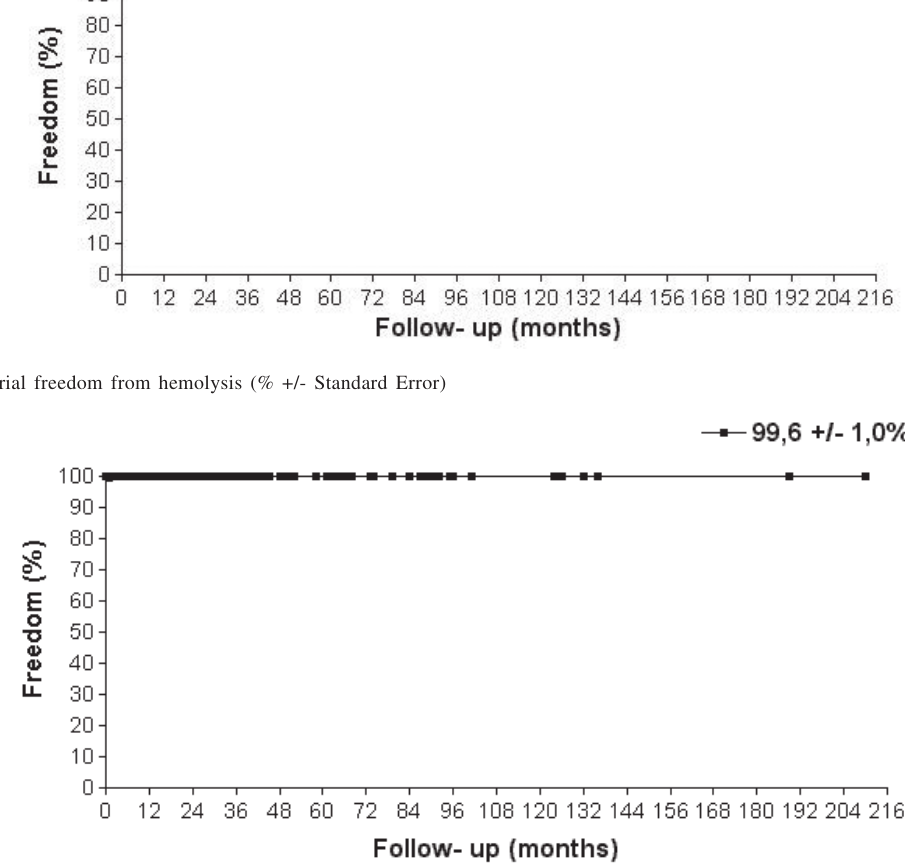
Figure 6 - Actuarial freedom from endocarditis (% +/- Standard Error)